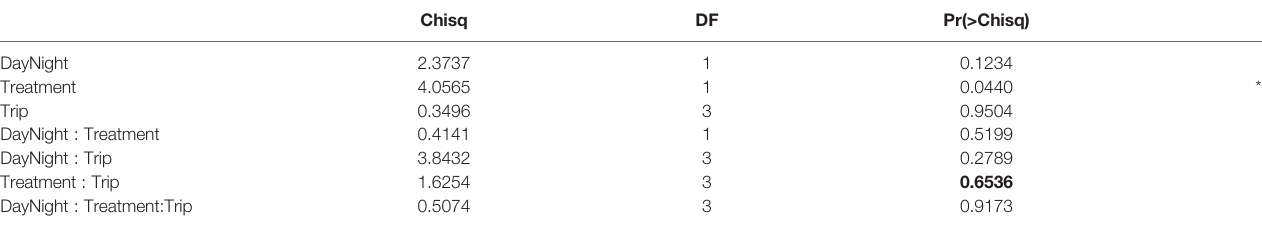
TABLE 4 | Generalised linear mixed effects model for zooplankton taxa richness